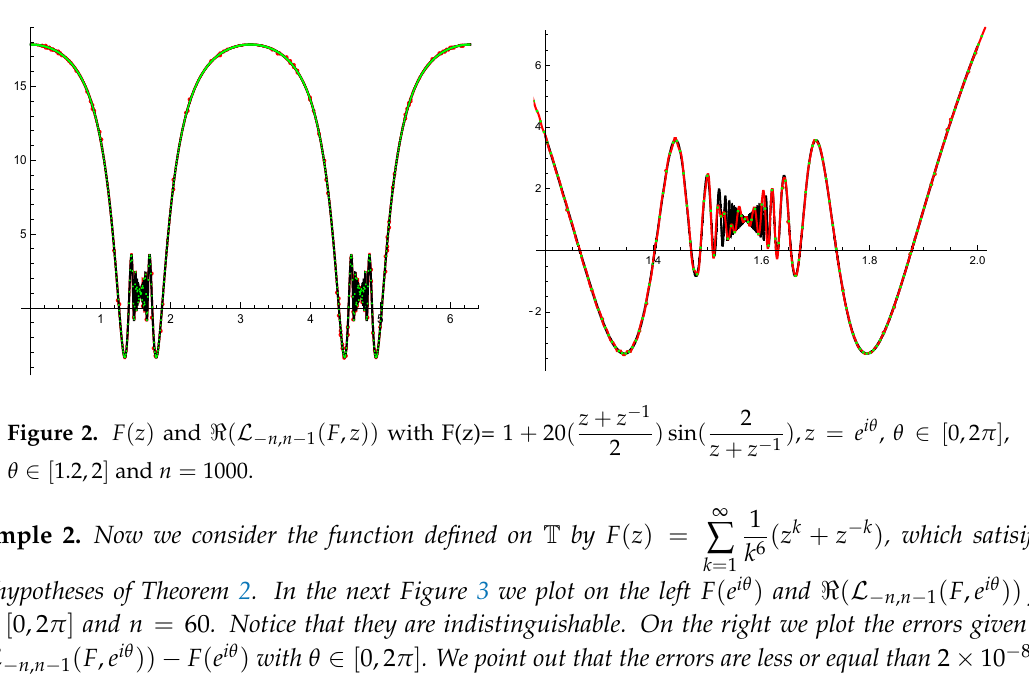
z + z − 1 2 ) sin ( ) , z = e i θ , θ ∈ [ 0,2 π ] , 2 z + z − 1